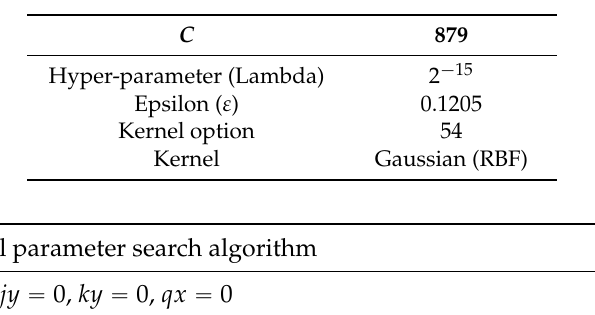
Figure 3. Flow chart of the procedure for obtaining optimal parameters (Table 1) for the proposed SVR model. Table 1. Optimal parameters for the proposed Support Vector Regression model.